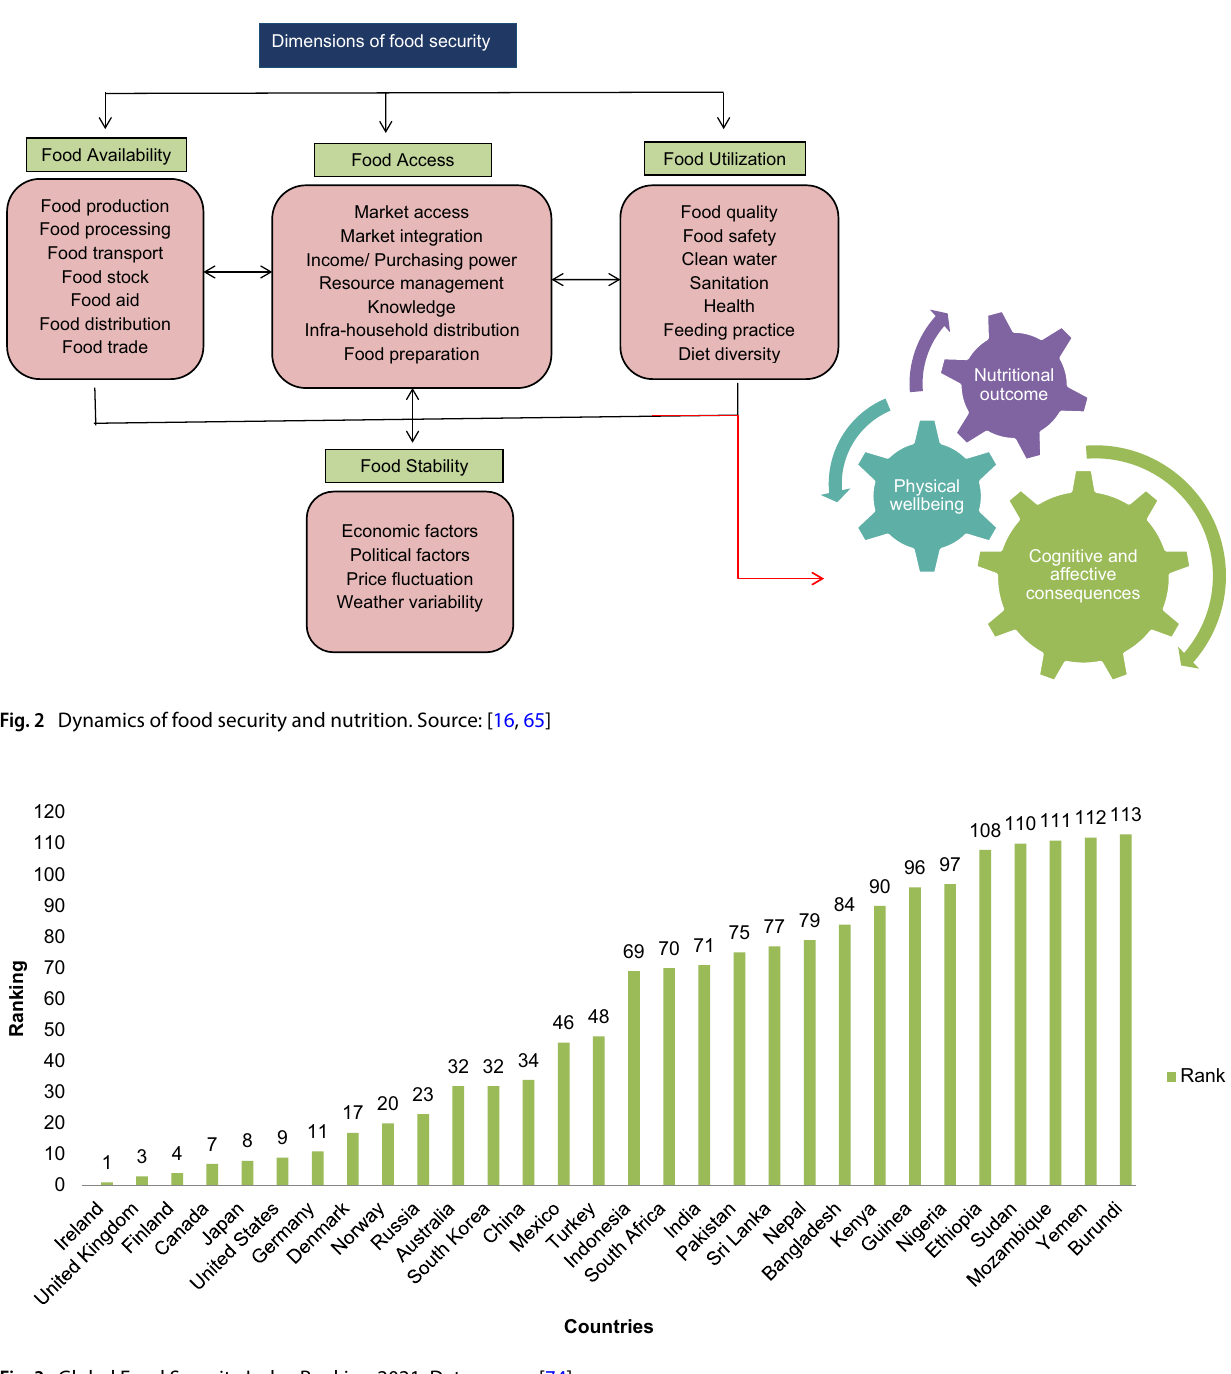
Fig. 3 Global Food Security Index Ranking 2021. Data source